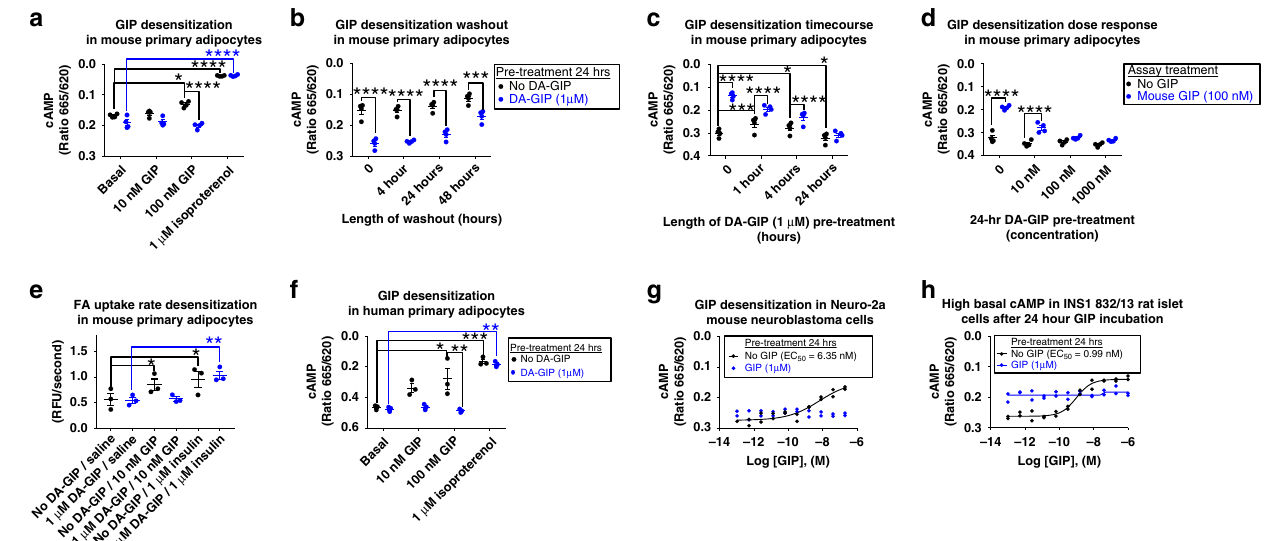
Fig. 7 Chronic GIPR agonism desensitizes GIPR activity in primary adipocytes. a cAMP measurements in primary differentiated mouse pre-adipocytes pre-treated with or without DA-GIP (1 μ M) for 24 h then treated with vehicle, mouse GIP, or isoproterenol (1 μ M) for 30 min; * p = 0.010, **** p ≤ 0.0001. b cAMP measurements in primary differentiated mouse pre-adipocytes pre-treated with or without DA-GIP (1 μ M) for 24 h, washed, then treated with 100 nM mouse GIP for 30 min; *** p = 0.0003, **** p ≤ 0.0001. c cAMP measurements in primary differentiated mouse pre-adipocytes pre-treated with or without DA-GIP (1 μ M) for 1, 4, or 24 h, then treated with 100 nM mouse GIP for 30 min; **** p ≤ 0.0001, *** p = 0.0003, 0/No GIP vs. 4 h/No GIP * p = 0.021, and 0/No GIP vs. 24 h/No GIP * p = 0.027. d cAMP measurements in primary differentiated mouse pre-adipocytes pre-treated with or without DA- GIP for 24 h, then treated with 100 nM mouse GIP for 30 min. **** p ≤ 0.0001. e FA uptake in primary differentiated mouse pre-adipocytes pre-treated with or without DA-GIP for 24 h, then treated with vehicle, mouse GIP, or insulin for 30 min. * p = 0.015, No DA-GIP Basal vs. No DA-GIP/Insulin ** p = 0.0044, DA-GIP/Basal vs. DA-GIP/Insulin ** p = 0.0022. f cAMP measurements in primary human adipocytes differentiated in vitro pre-treated with or without DA-GIP for 24 h then treated with vehicle, human GIP, or isoproterenol for 30 min. * p = 0.011, *** p = 0.0009, 100 nM GIP/No DA-GIP vs. 100 nM GIP DA- GIP ** p = 0.0065, and Basal/DA-GIP vs. Isoproterenol/DA-GIP ** p = 0.0011. a – f Data represent means ± SEM of four mice with three wells/treatment/ mouse ( a – d ), three mice with three wells/treatment/mouse ( e ), three human donors with three wells/treatment/person ( f ); two-way repeated